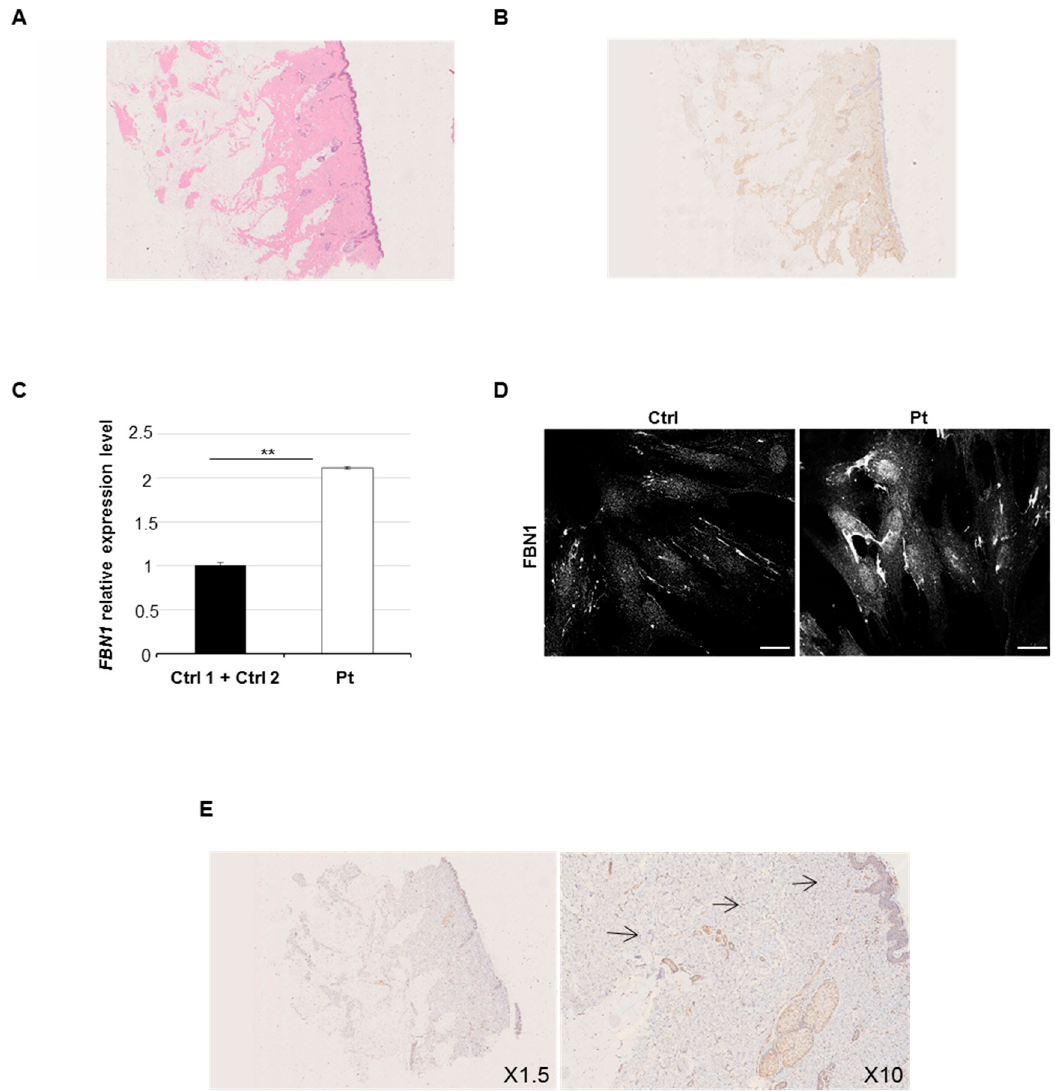
Figure 2. Immunohistochemistry and Fibrillin 1 gene ( FBN1 ) analysis. Dermal histology: ( A ) diffuse sclerosis of the dermis and subcutaneous fibroadipose tissue (hematoxylin–eosin staining, H&E X1.5); ( B ) collagen fibers deposition into subcutanous adipose tissue highlighted by trichrome staining and immunoreactivity for anti-CD34 Ab (X1.5). ( C ) Quantitative Real Time PCR (qPCR) was performed to measure FBN1 expression in patient and controls. Scale bars represent standard errors. ** p < 0.03, Student’s t-test. Ctrl, control; Pt, patient. ( D ) Confocal study showed an excessive microfibrillar aggregates in patient’s fibroblasts compared to controls by staining with anti-fibrillin 1 antibody (Ab). The panel reports only one representative image from one of the two control lines. Scale bar = 1 μ m (white line). ( E ) Immunostaining with anti-fibrillin Ab (X1.5 and X10 objectives) displayed collagen fibers expression in patient’s skin biopsy. Arrows indicate the staining with anti-fibrillin Ab.